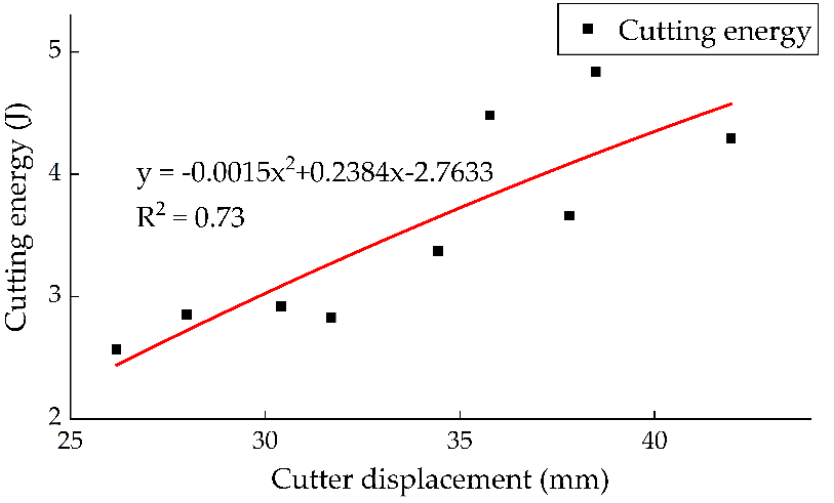
Figure 10. The e ff ect of cutter displacement at di ff erent positions on cutting Figure 10. The effect of cutter displacement at different positions on cutting energy.